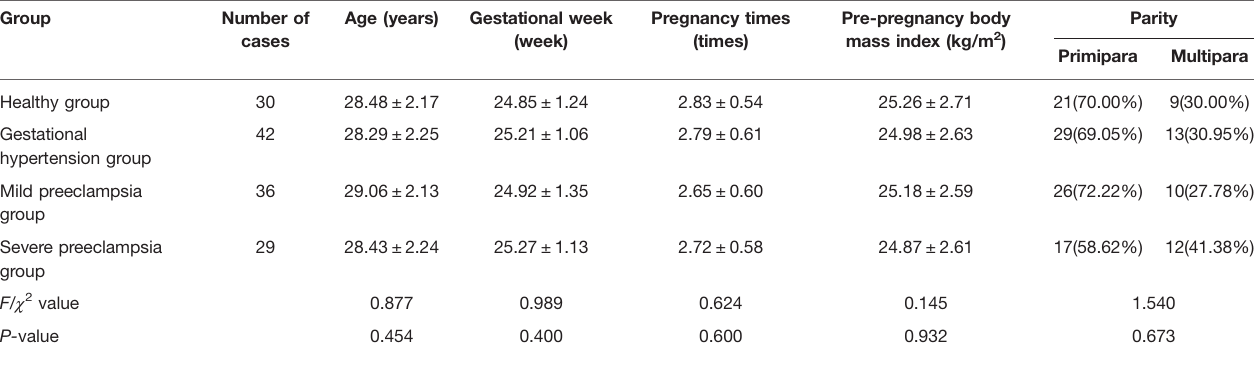
TABLE 1 | Comparison of general data in each group ( n , %, x +